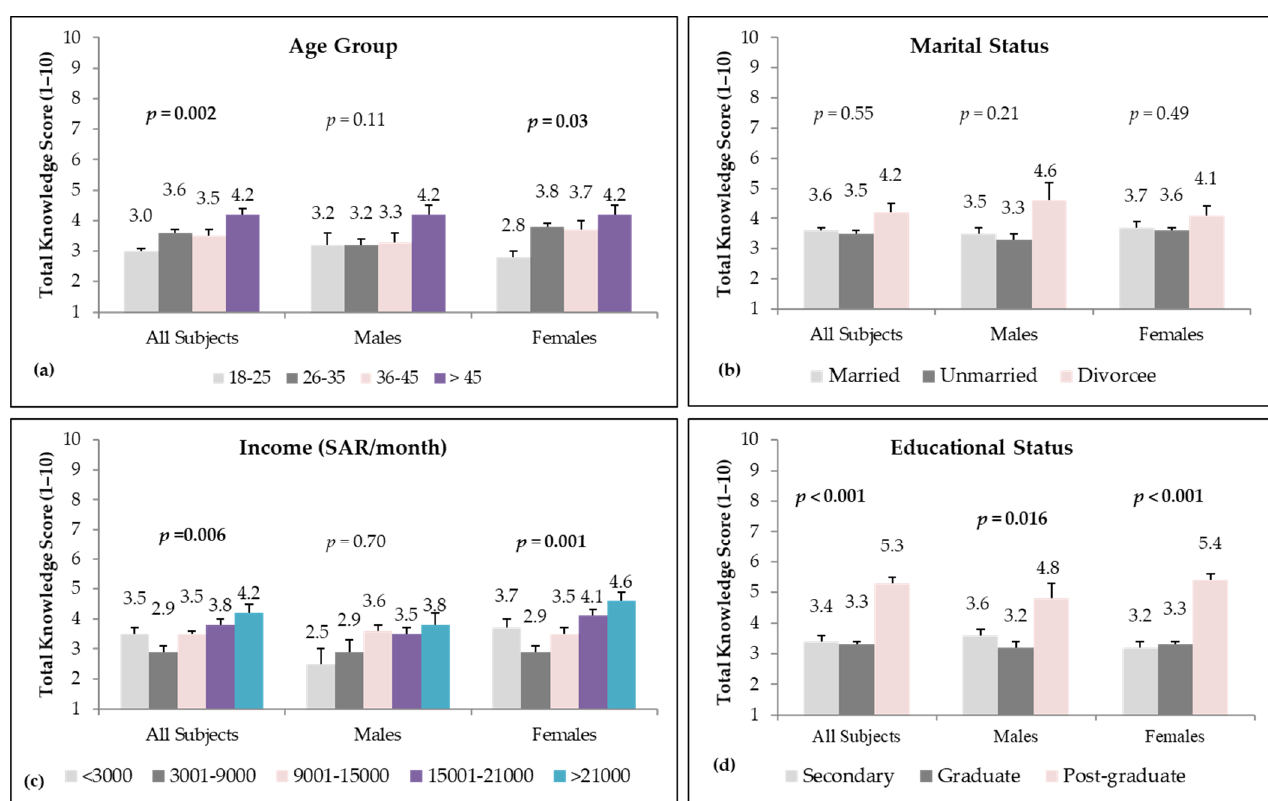
Figure 2. A bar graph depicting the kale knowledge scores in study participants divided according to ( a ) age group, ( b ) marital status, ( c ) income and ( d ) educational status. The error bar shows the standard error of the mean.